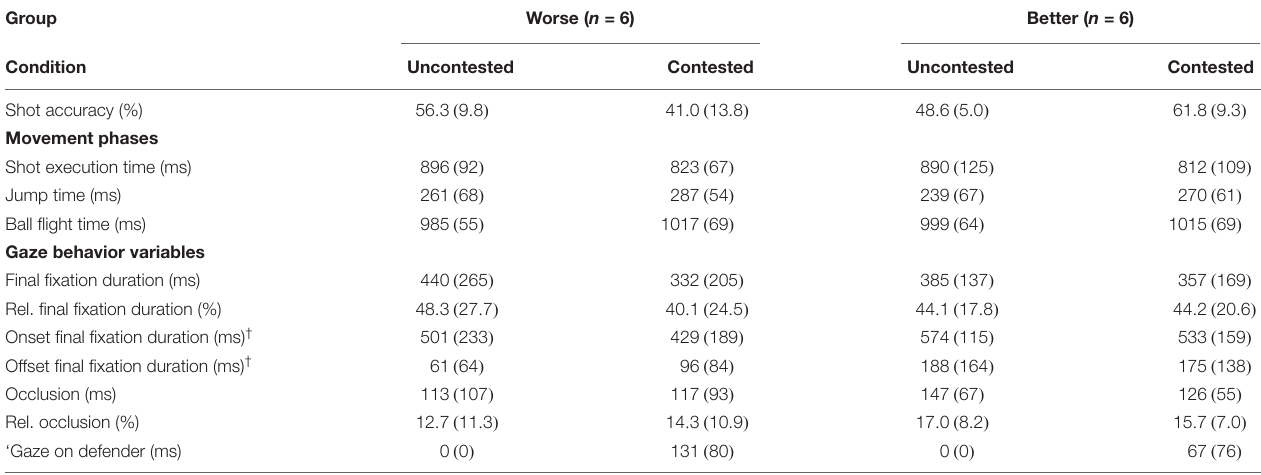
TABLE 2 | Mean ( SD ) shooting accuracy, duration of movement phases, and gaze behavior variables for the participants with worse and better performance (in the contested compared to the uncontested condition), in the uncontested and contested conditions. For definitions of the phases and durations, we refer to the text (see section “Data